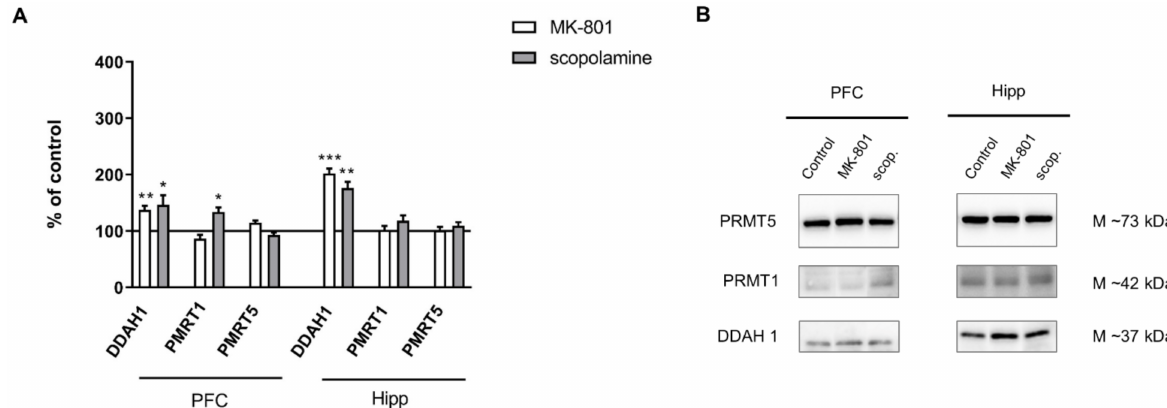
Figure 6. DDAH1, PMRT1 and PMRT5 expression in the prefrontal cortex (PFC) and hippocampus (Hipp) after acute administration of MK-801 (0.3 mg/kg) or scopolamine (1 mg/kg) ( A ). Representative Western blots ( B ). Data are presented as means ± SEM. * p < 0.05; ** p < 0.01; *** p < 0.001 vs. control.